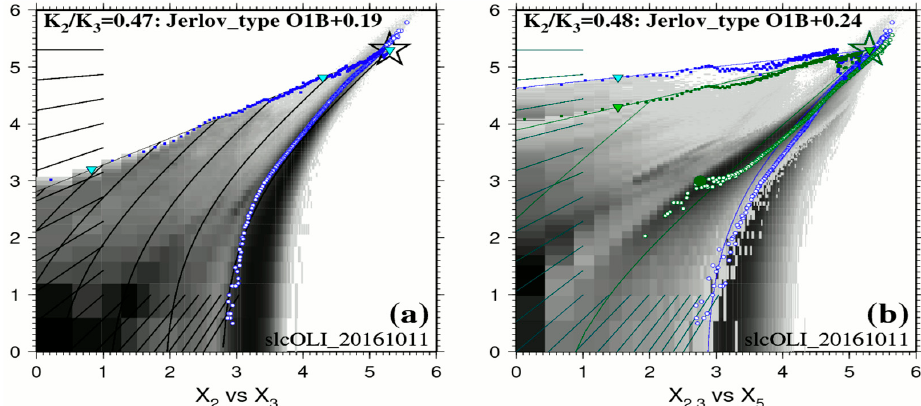
Figure A4. Plot of linearized calibration data (Equation (4)) for the whole of the 11 October 2016 scene. Bands 2, 3 and 5 are Blue, Green and Red, respectively. ( a ) is the calibration diagram of linearized Blue (X 2 ) and Green (X 3 ) and reports estimated K 2 /K 3 values with Jerlov water types. ( b ) is the calibration diagram for Blue (X 2 ), Green (X 3 ) and Red (X 5 ) bands respectively. The backdrop in shades of gray represents the bi-dimensional histogram for all image pixels (white ROI in Figure 1). Blue dots are the actual pixels used for BPL calibration, each referenced to its row/line position in the image. Small white circles represent the scatter of averaged bare land pixels, as a proxy for the Soil Line. The 11 October 2016 scene offers a nice and straightforward optical calibration diagram for very clear waters. In Figure A4a, the BPL pixels (blue dots) display along a straight line over a depth range